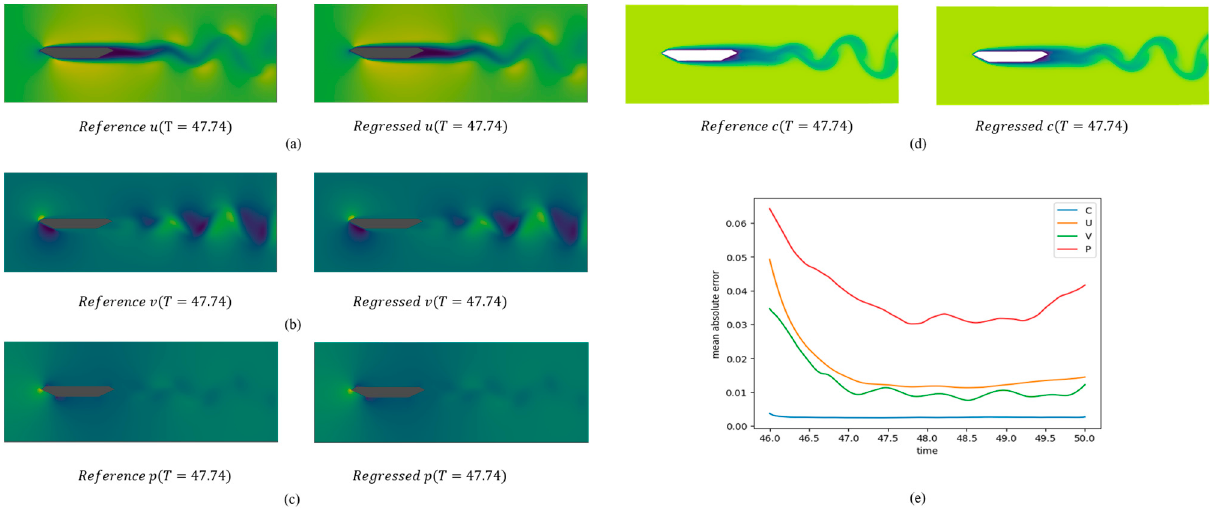
Figure 6. Comparison between predicted data and CFD data for Re = Pe = 1250: ( a ) u component; ( b ) v component; ( c ) p; ( d ) c; ( e ) mean absolute error.